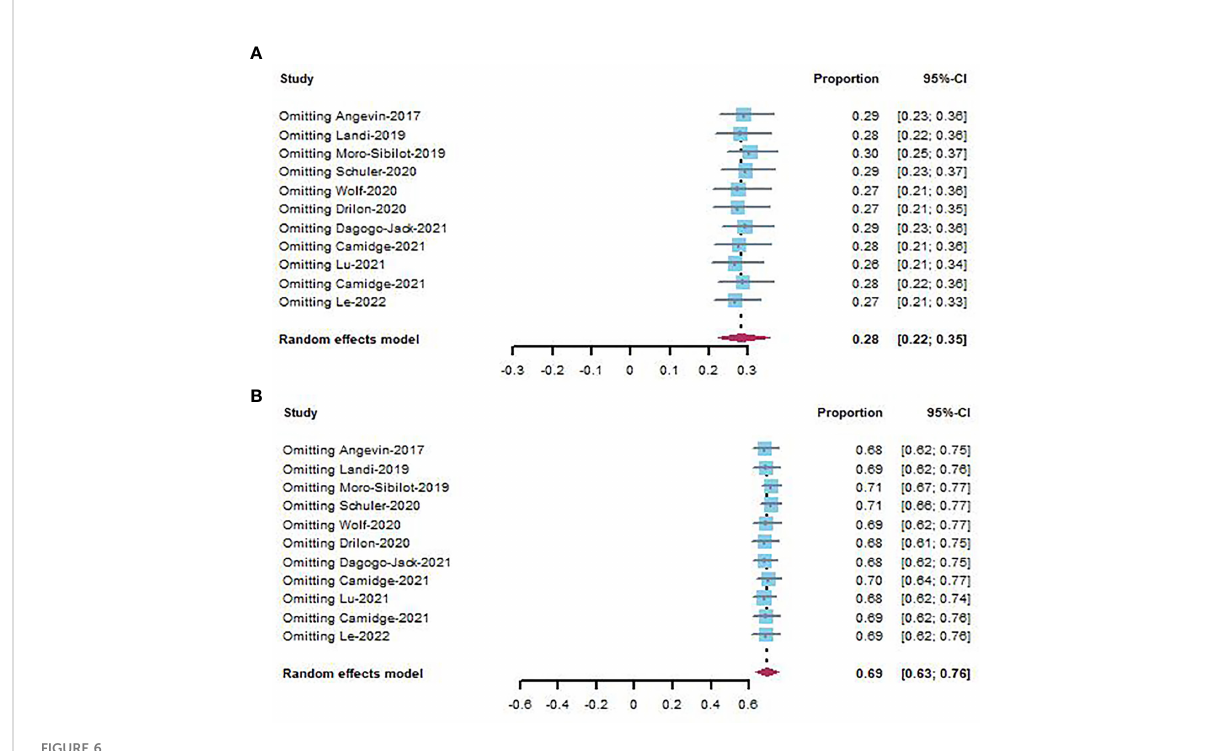
FIGURE 6 Sensitivity analysis of ORR (A) and DCR (B) in NSCLC studies.